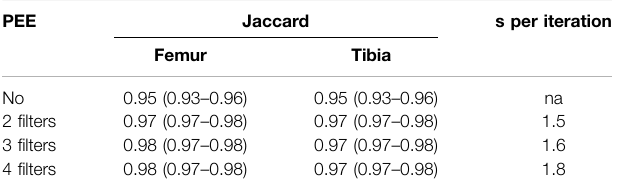
TABLE 2 | Results (median and IQR values) of the ablation test performed on the CEL-Unet about the effect ofPEE module. Theadditional computational effort (seconds per iteration), with respect to the removal of the PEE module, were reported.